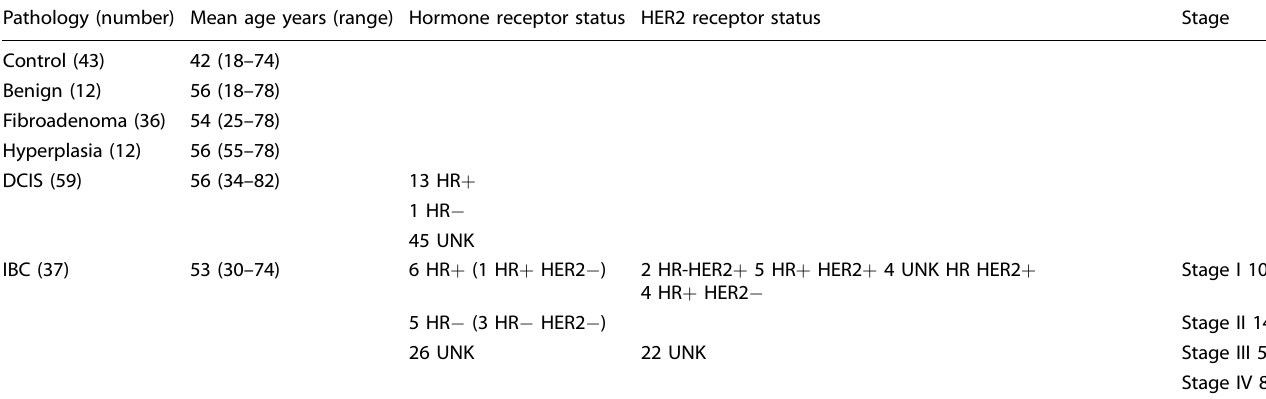
Table 2. Clinical and pathologic data of the serum samples. Pathology (number) Mean age years (range) Hormone receptor status HER2 receptor status